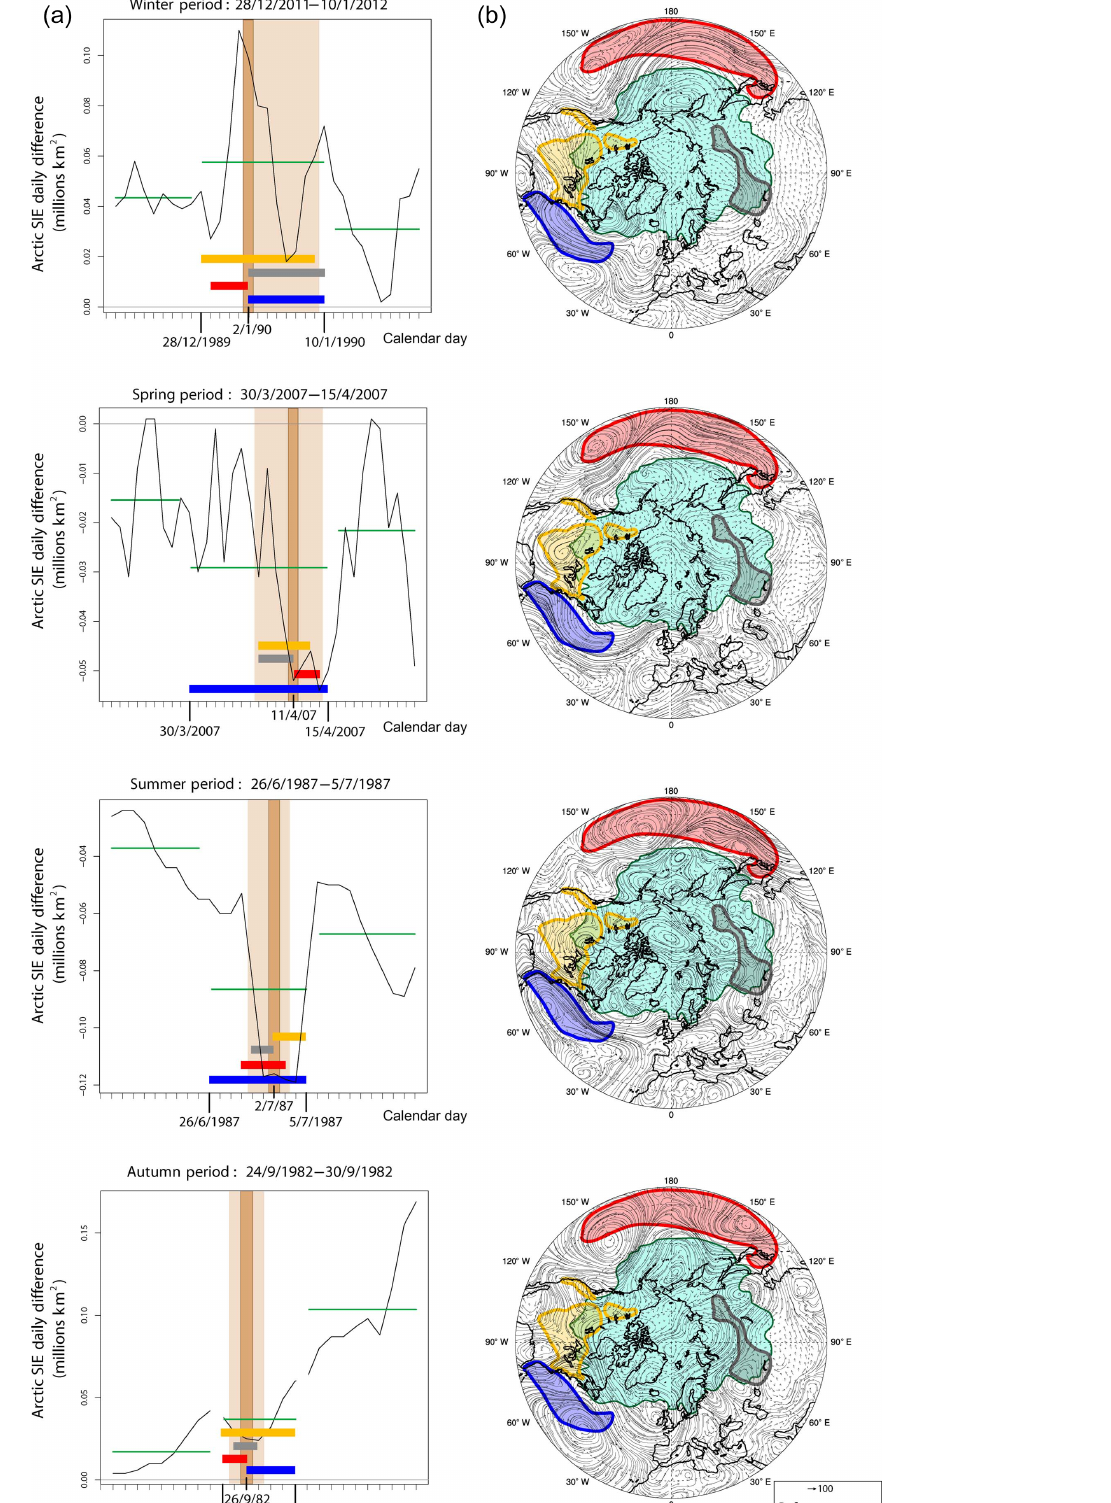
Figure 9. Four selected cases of Ext-MTP (mmday − 1 ), one for each season. (a) Daily change in SIE (black line), extreme MTP periods for each of the sources (horizontal bars in colour), coincident extreme MTP for the sources (the light brown vertical bar shows when there are three coincident MTPs, and the dark brown vertical bar shows when there are four coincident MTPs), and averages of the daily change in SIE for different periods (green horizontal bars). (b) Vertical integrated moisture flux plotted for the day on which the Ext-MTP